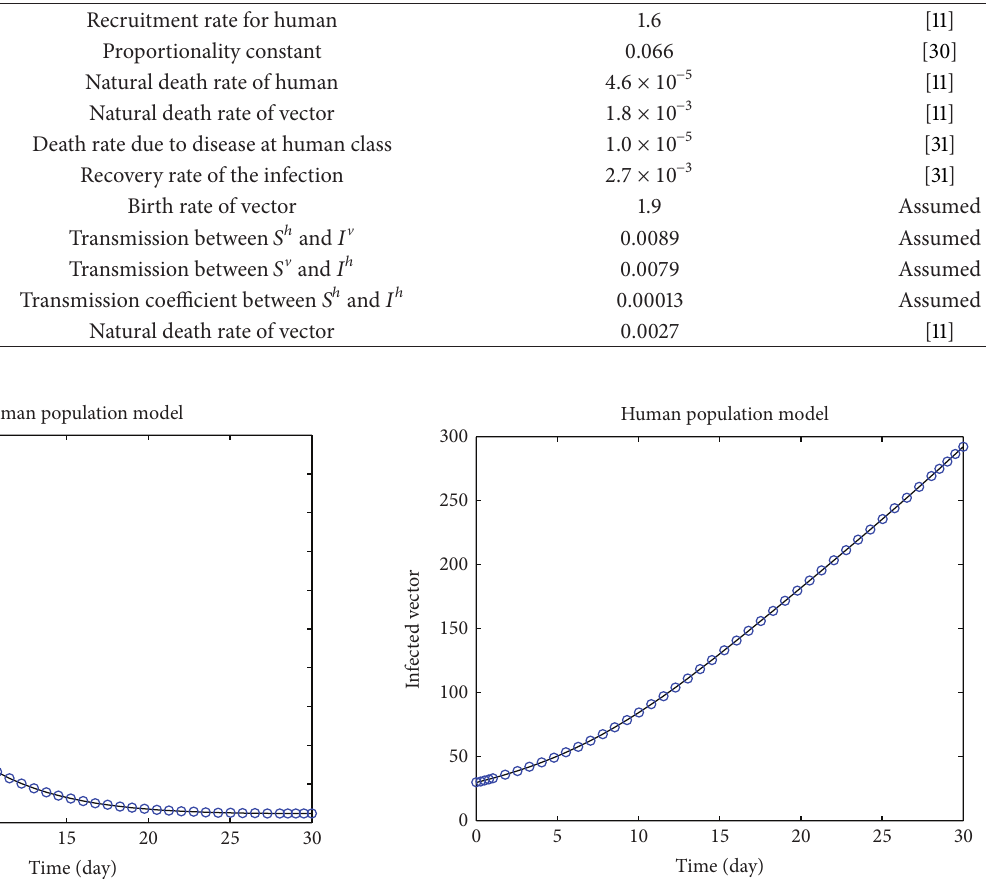
Figure 3: Comparison of RK method (dotted line) and MSGDTM (solid line).